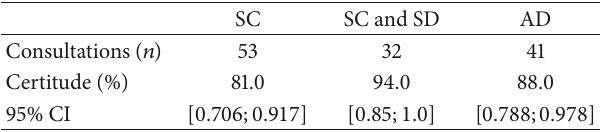
Table 5: Results obtained when the Special Case (SC), the Strong Demarcation and Special Case (SD and SC), and the Asymmetrical Distribution (AD) were